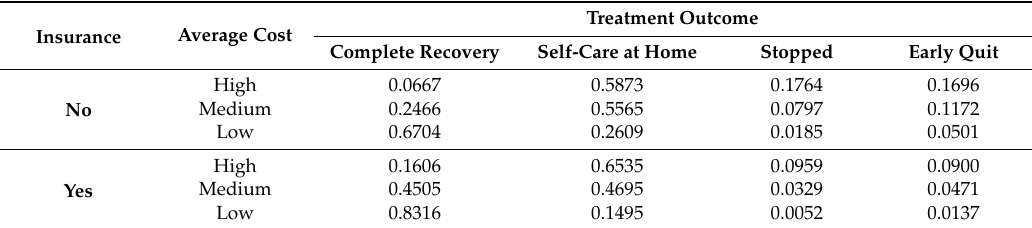
Table 14. Treatment outcome probabilities conditioned on insurance and average cost.